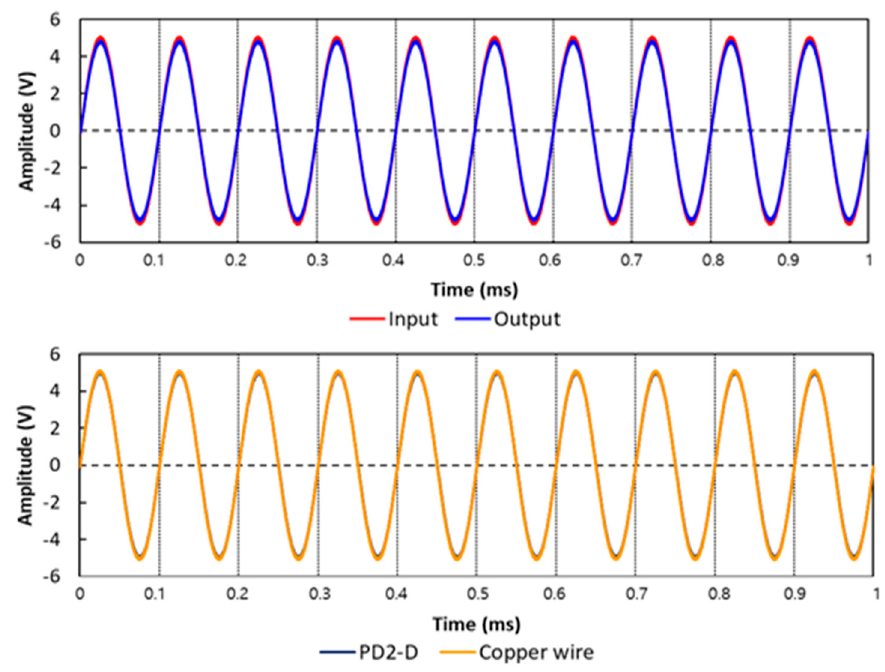
Figure 5. Comparison of waveforms between the input signal and output signal of the samples, and comparison of waveforms between copper wire and the sample PD2-D. Table 6. Pearson’s correlation coefficient between output signals of the sample and copper wire. Table 5. Pearson’s correlation coefficient between I/O signals of the samples.